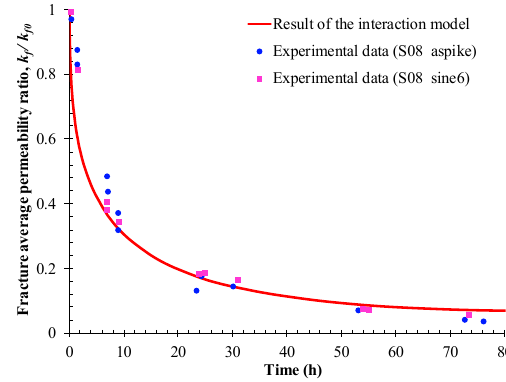
Figure 20. Evolution of coal average permeability ratio.